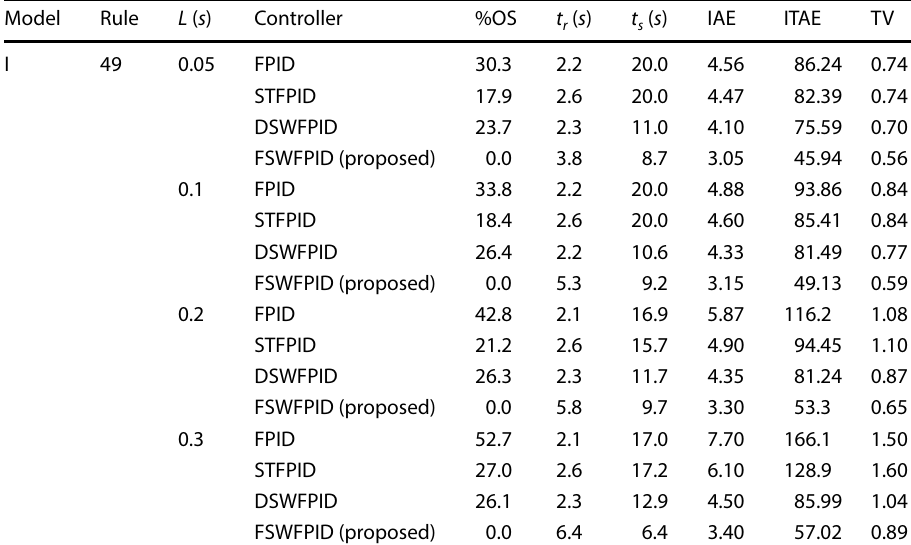
Table 5 Performance analysis for Model I